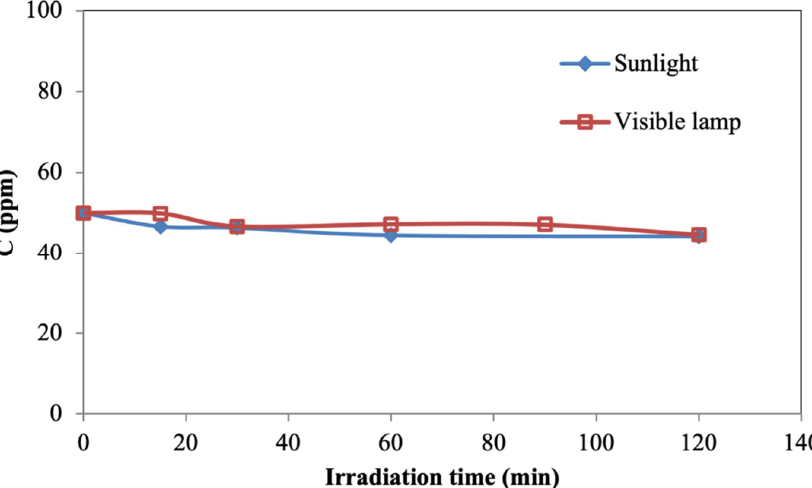
Figure 7. Pollutant degradation by photolysis in absence of photocatalyst, using both sunlight and visible lamp.